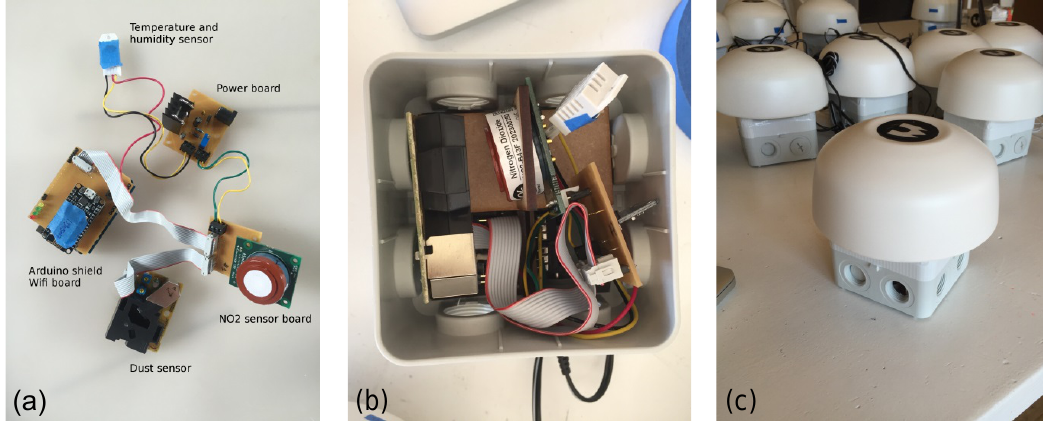
Figure 2. Hardware modules of a sensor device (a) , and the integration in the casing: open (b) and closed (c) .